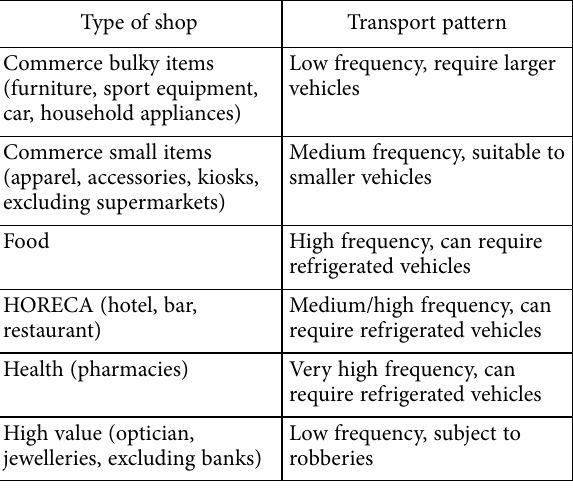
Table 2. Different typologies of commercial activities and the related transportation